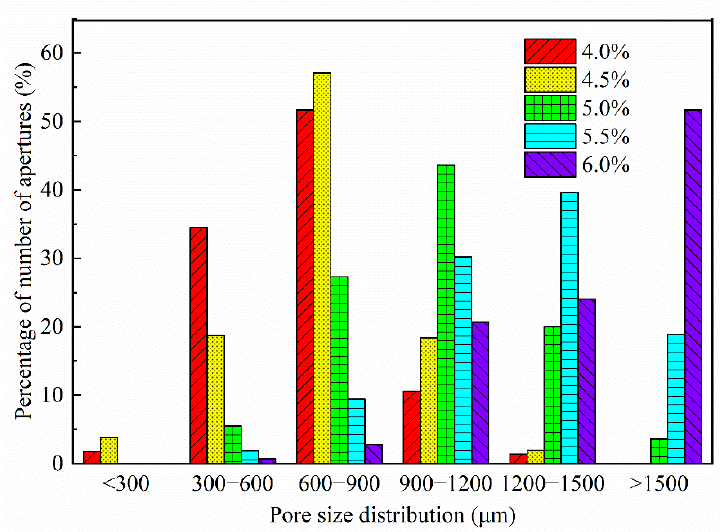
Figure 13. Effect of hydrogen peroxide dosing on pore size distribution.